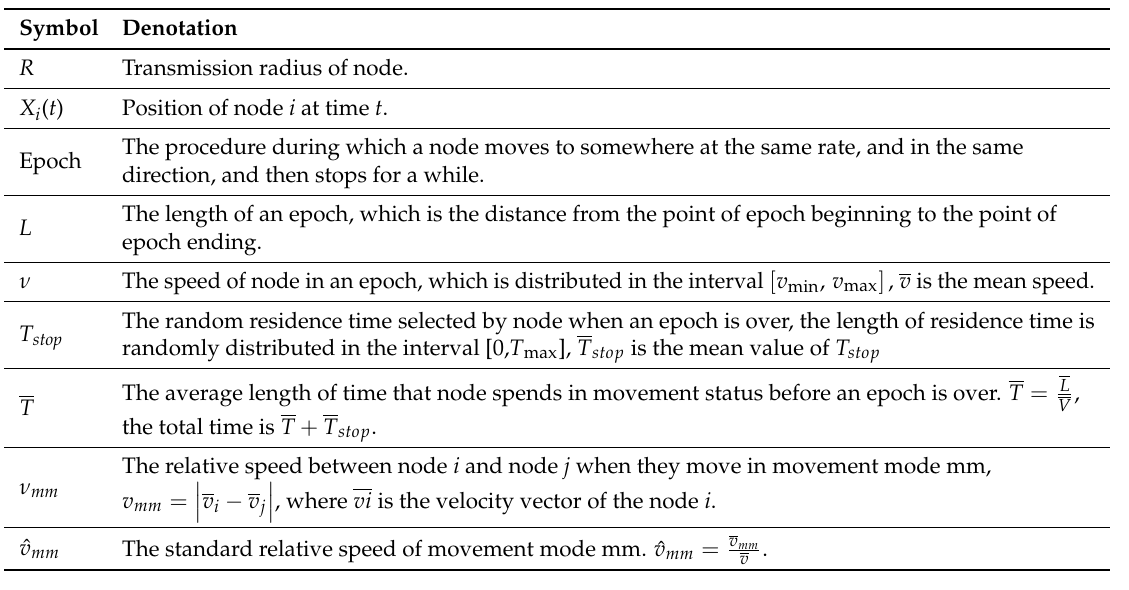
Table 1. Symbols and